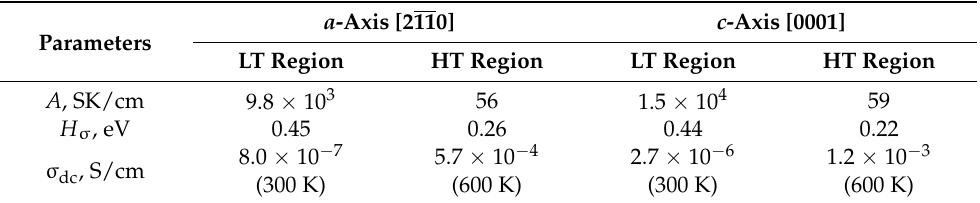
Table 2. Parameters of the calculated static bulk conductivity of CeF 3 single crystals in different crystallographic directions for low- (300–355 K) and high (545–600 K)-temperature ranges.